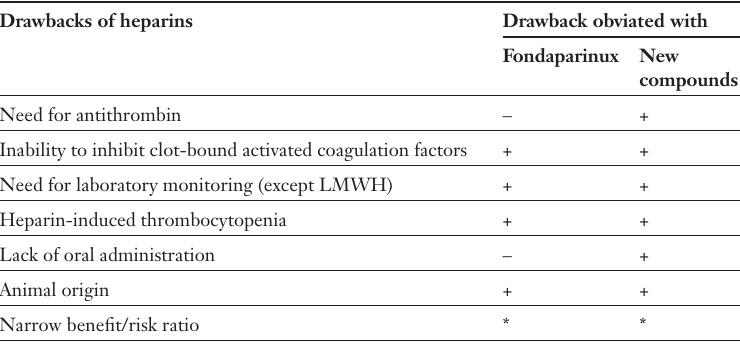
Drawbacks of heparins (UFH and LMWH) and comparison with fondaparinux and new oral synthetic direct factor Xa or thrombin inhibitors (“new